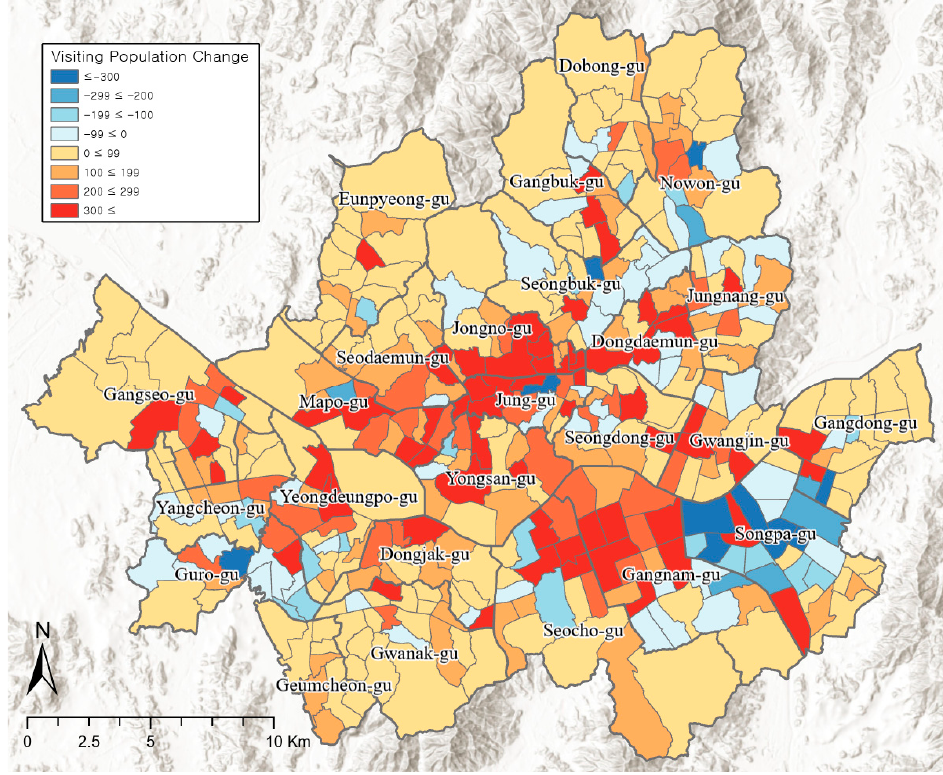
Figure 2. Spatial distribution of visiting population differences between weekends with high PM concentrations and control days.